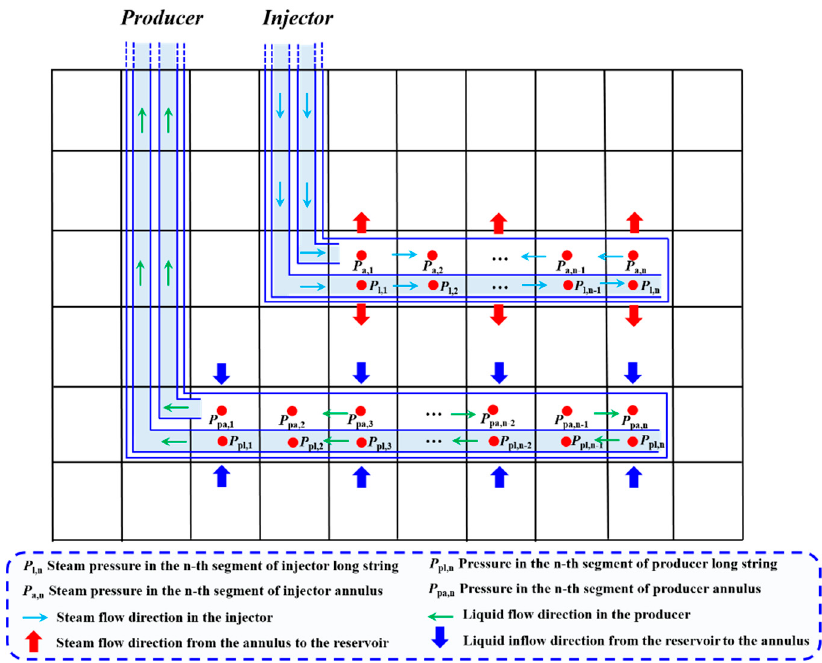
Figure 4. The schematic with discretized grids and major parameters.